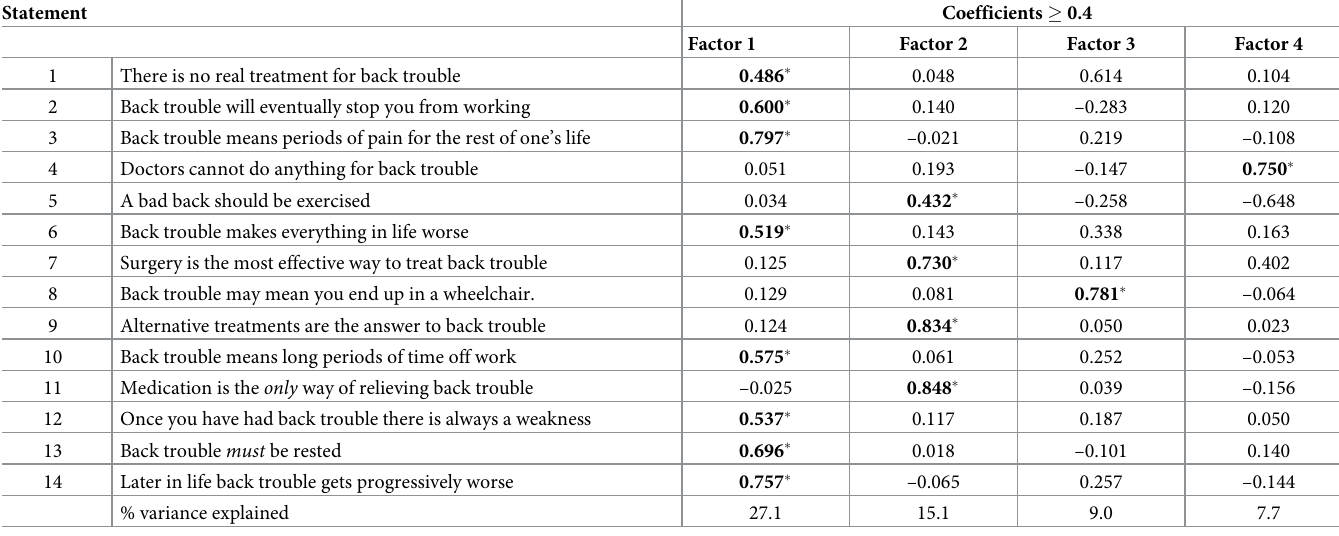
Table 3. Factor structure of the Hausa Back Beliefs